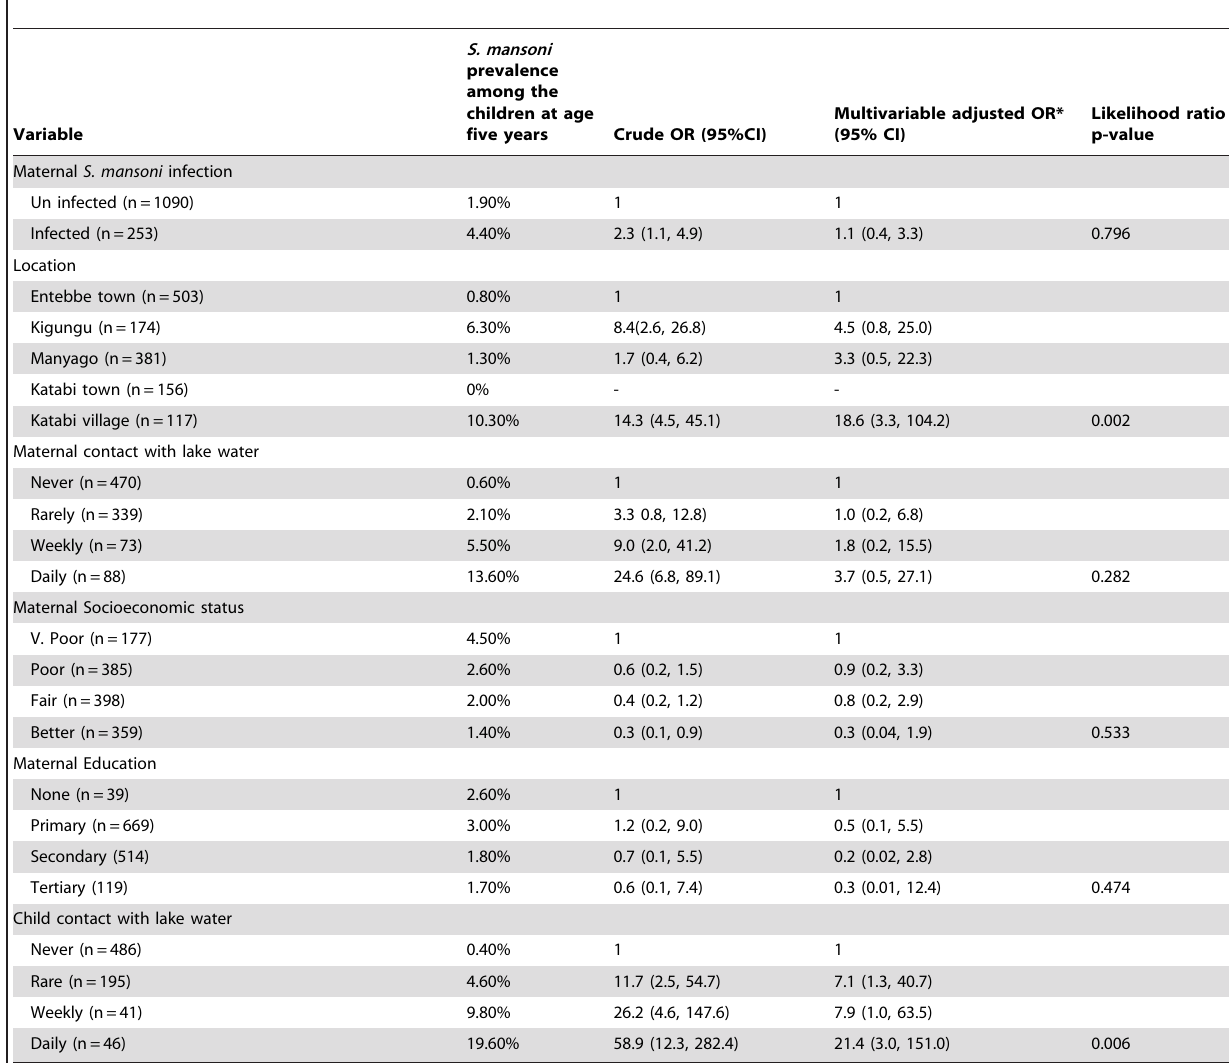
Table 2. Factors associated with S. mansoni infection among children at age five years old.